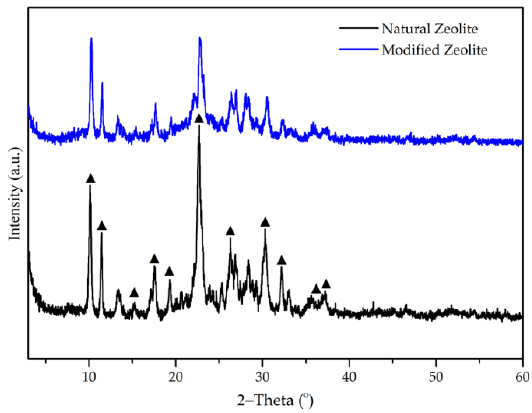
Figure 1. XRD patterns of natural and modified zeolite.